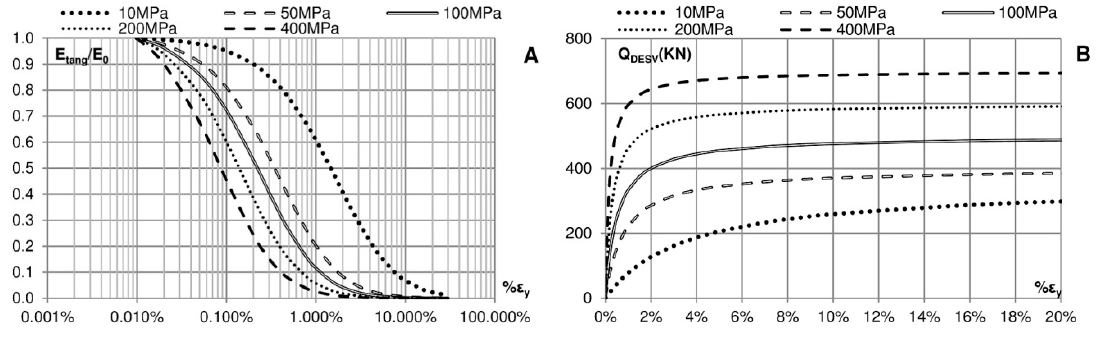
Figure A6. ( A ) Stress–strain relation and ( B ) Young’s modulus variation with deformation of the soil.